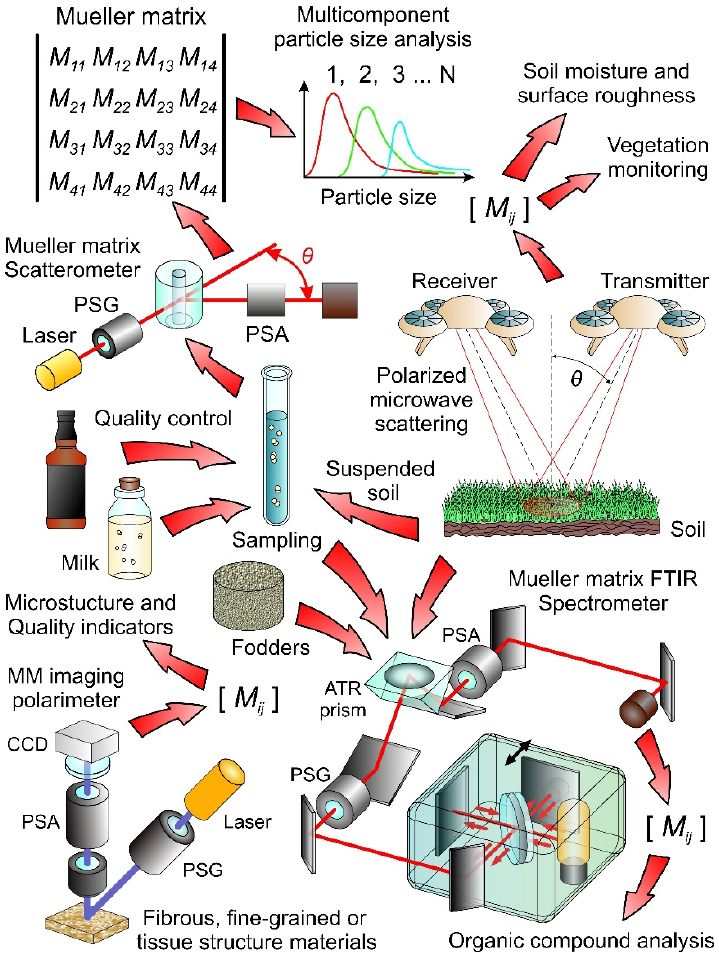
Figure 8. Main directions for the application of MMP in agriculture.